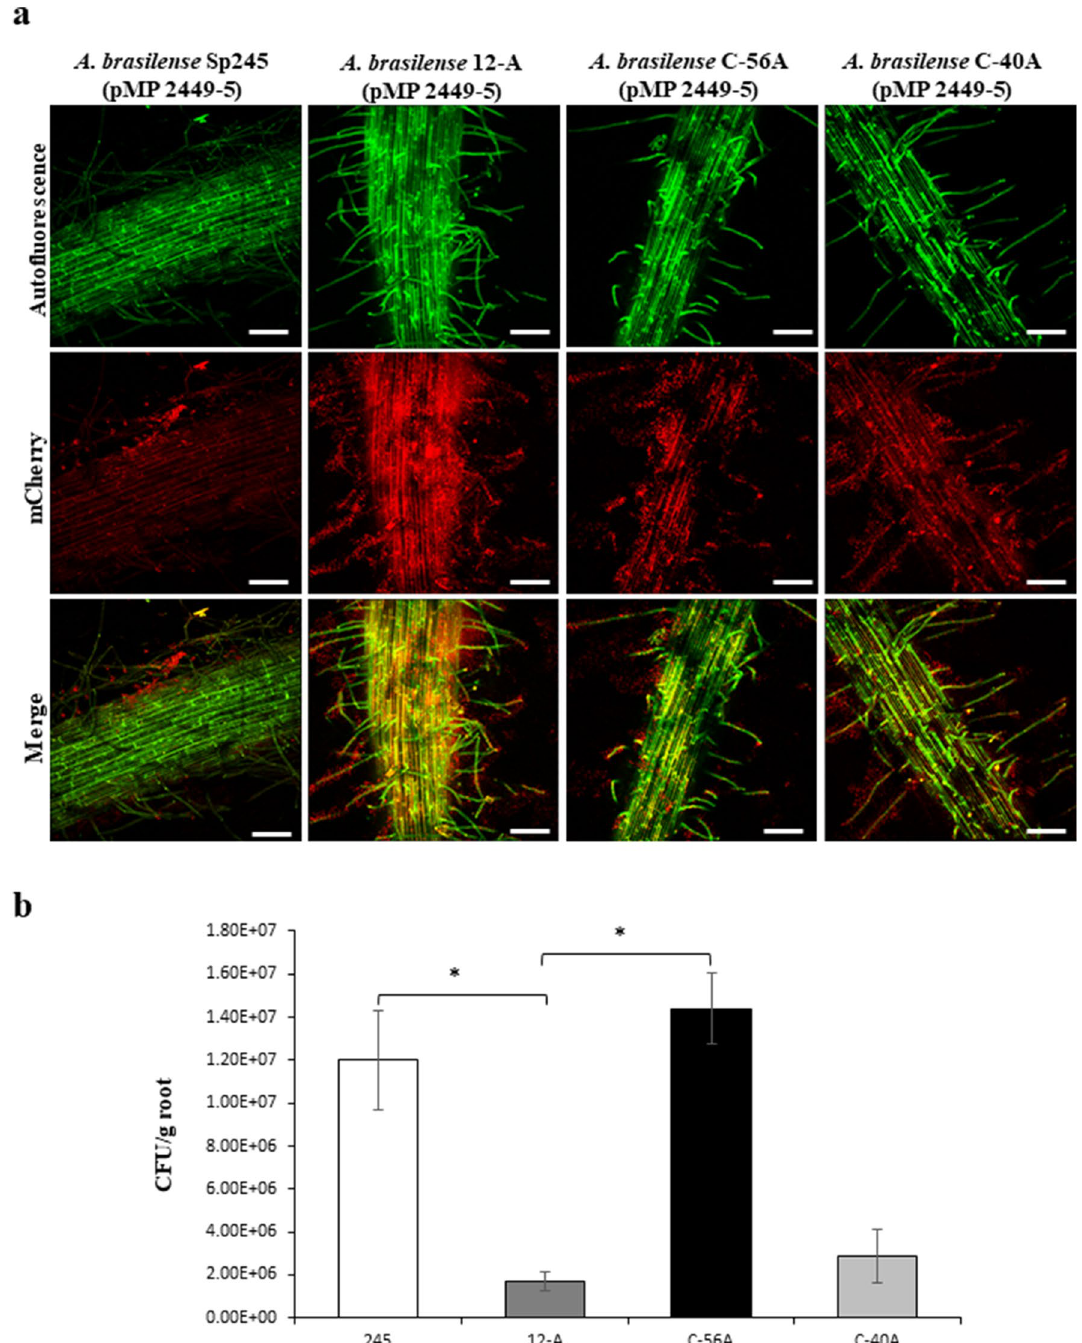
Figure 7. Rhizosphere colonization of A. brasilense Sp245, the 12-A mutant, the C-40A control mutant and the C-56A complemented mutant and visualization of tagged colonizing bacteria by CLSM. ( a ) The plants were grown in glass tubes with Hoagland hydroponic solution and examined at 7 days postinoculation with 5 × 10 6 –10 7 CFU/mL of A. brasilense Sp245 (pMP2449-5), A. brasilense 12-A (pMP2449-5), A.brasilense C-40A (pMP2449-5) and A. brasilense C-56A (pMP2449-5) (the WT, mutant, and complemented mutant strains, respectively). Subsequently, the cells showing mCherry fluorescence were visualized using CLSM with an excitation wavelength of 561 nm, with fluorescence emission captured between 585 and 615 nm. Thereafter, the images were edited using the standard NIS elements in Nikon software. The bar corresponds to 10 µm. ( b ) The bacterial colonies recovered from the rhizosphere 1 week after inoculation under sterile soil conditions were tested for antibiotic resistance to distinguish the control and mutant strains and were counted. CFU/mL per gram of plant root values are presented on a logarithmic scale. Each experiment was repeated three times with five plants per experiment. Asterisks represent the statistical significance of the data ( P < 0.05) according to Student’s t-test by SigmaPlot (Systat Software, San Jose,